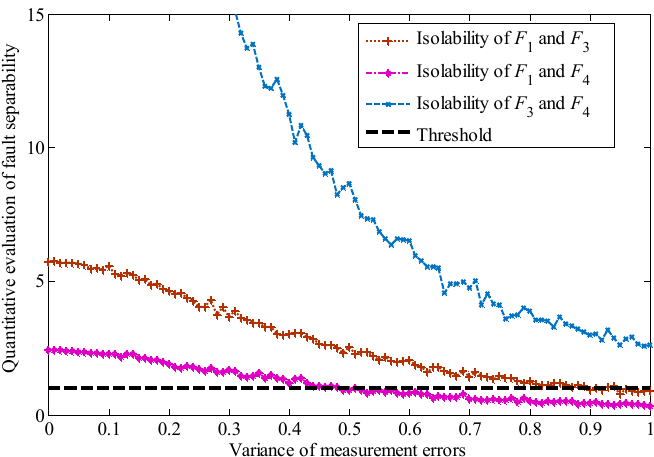
Figure 9. Quantitative evaluation of fault isolability under small faults.